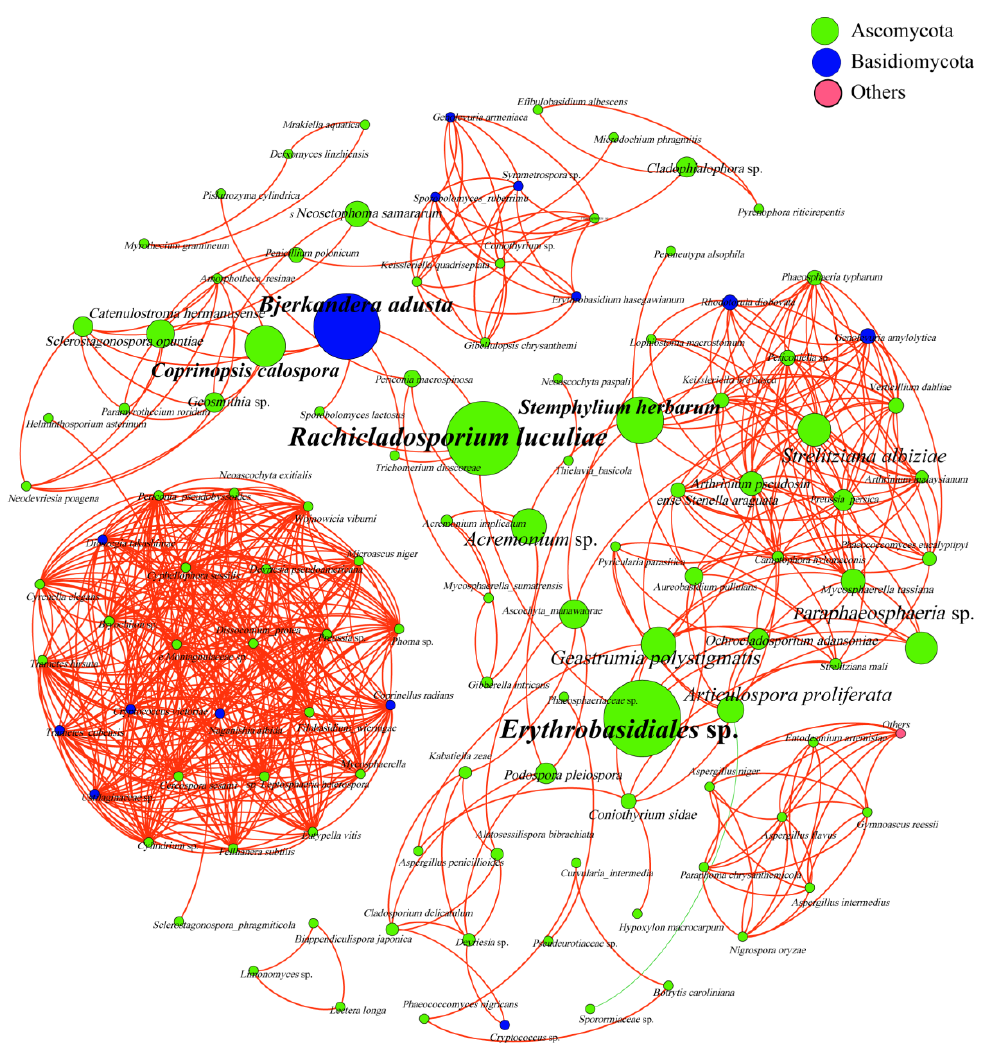
Figure 6. Co-occurrence network of microbial taxa in the four native grasses. Nodes represent fungal species, whereas edges represent positive and negative connections between pairs of species.